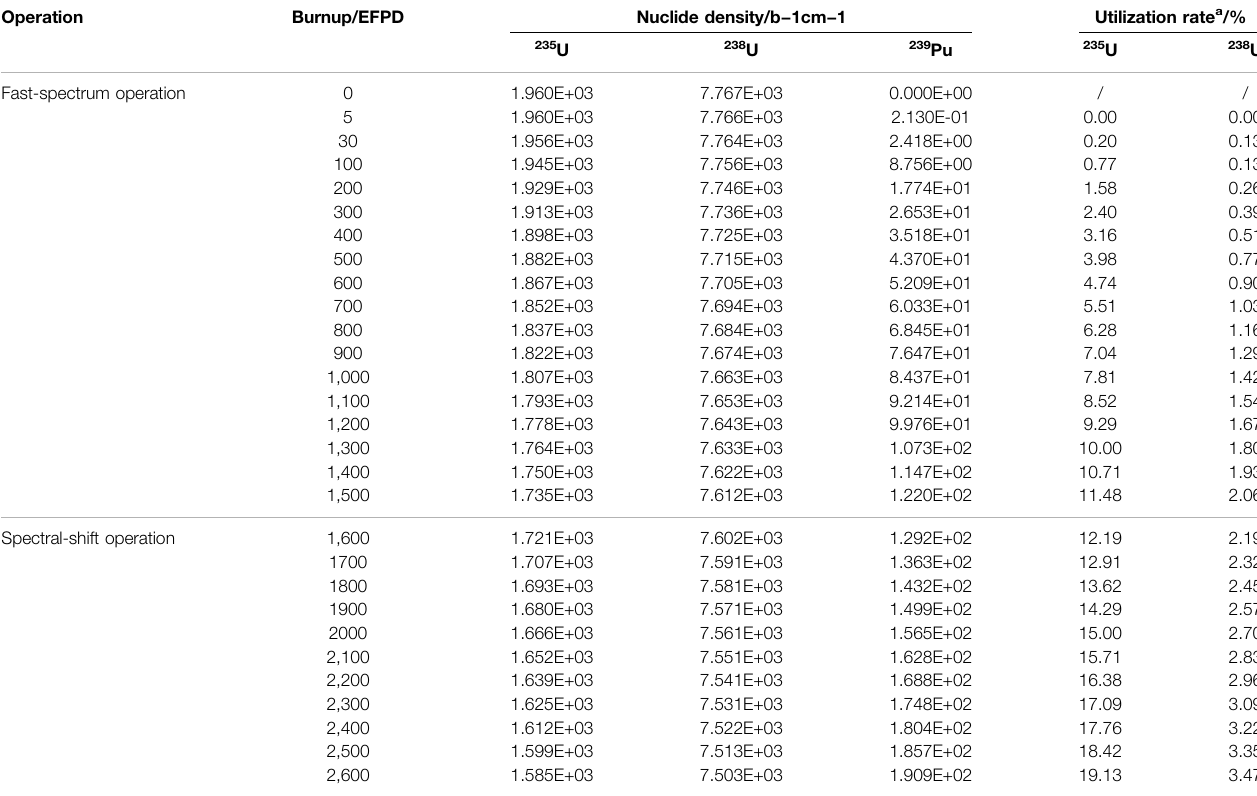
TABLE 4 | Density of typical nuclides in the spectral-shift scheme.